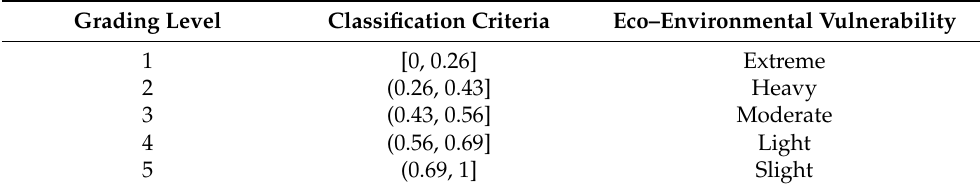
Table 5. Classification criteria of eco–environmental vulnerability.